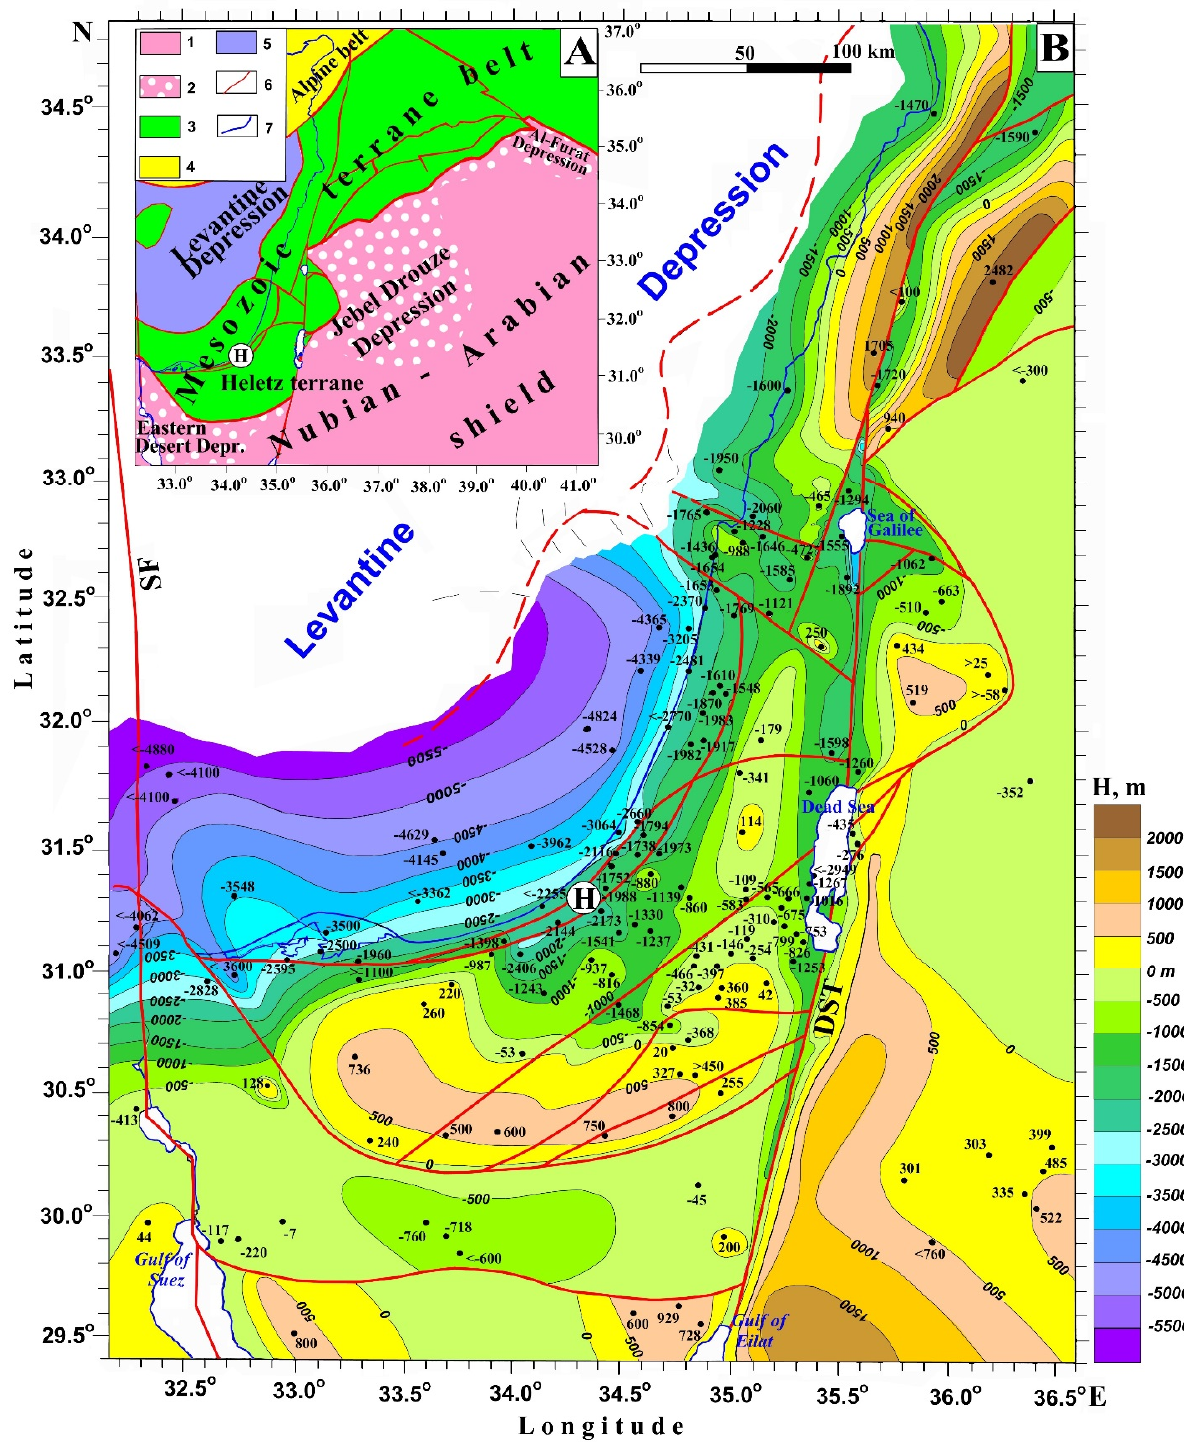
Figure 1. ( A ): Areal tectonic map, ( B ): Structural–neotectonic map of the base of the newest (post- Jurassic sediments) tectonic complex. (1) Precambrian Craton, (2) Precratonic Depression, (3) Mes- ozoic terrane belt, (4) Alpine Mediterranean Belt, (5) Tethyan oceanic crust, (6) faults, (7) coastline. SF, Sinai Fault, DST, Dead Sea Transform. ( B ) revised after [12].